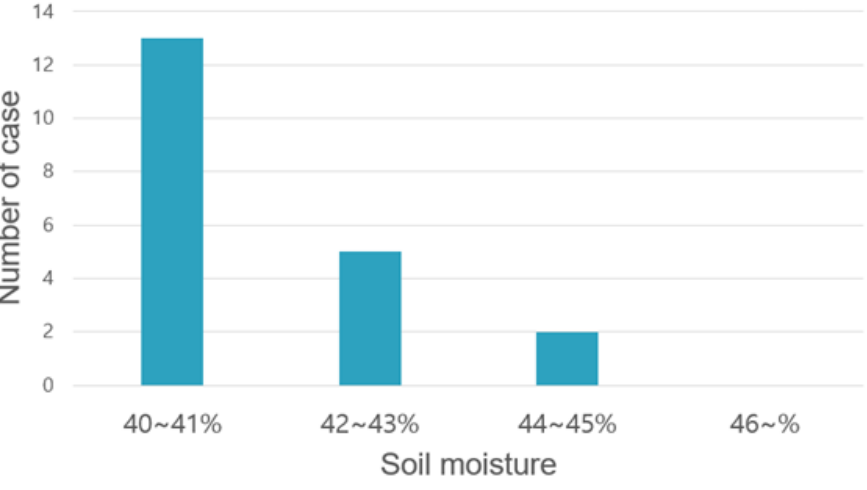
Figure 21. Case distribution depending on the maximum soil moisture in edge-level closed-loop control.